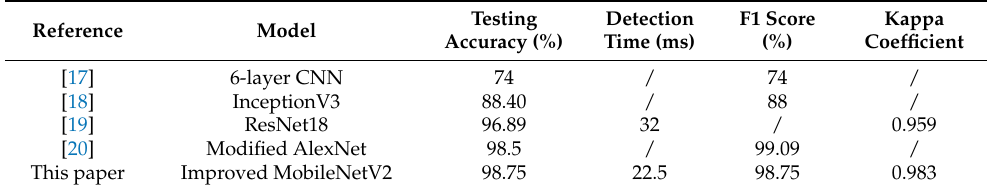
Table 4. Performance comparison between published papers and this